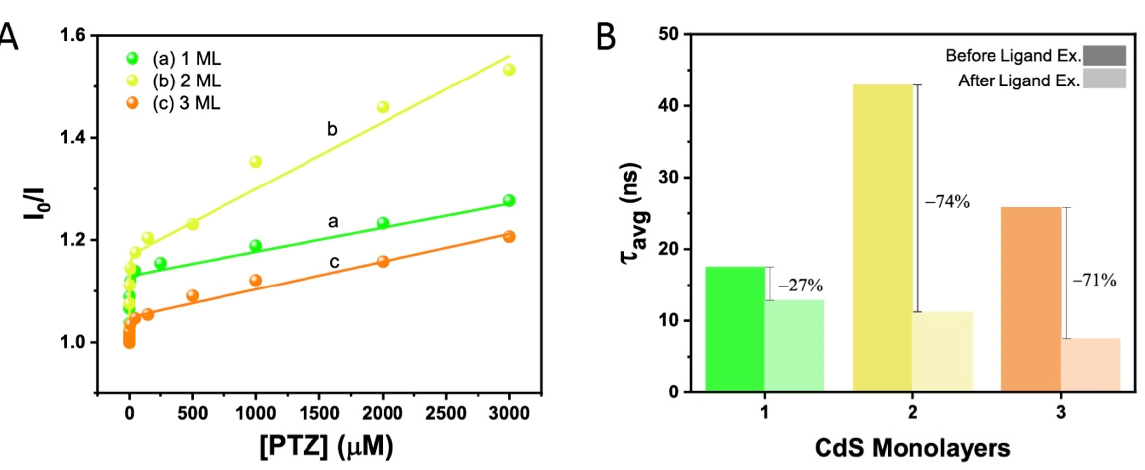
Figure 3. PL quenching experiment probing hole-transfer capabilities of the NRs. ( A ) Stern–Volmer plot of PL quenching in the presence of increasing amounts of PTZ as a hole scavenger in toluene. I 0 and I are the PL intensity in the absence and presence of PTZ, respectively. ( B ) Average PL lifetime of NRs with native ODPA and with MPA ligands measured in water as solvent.